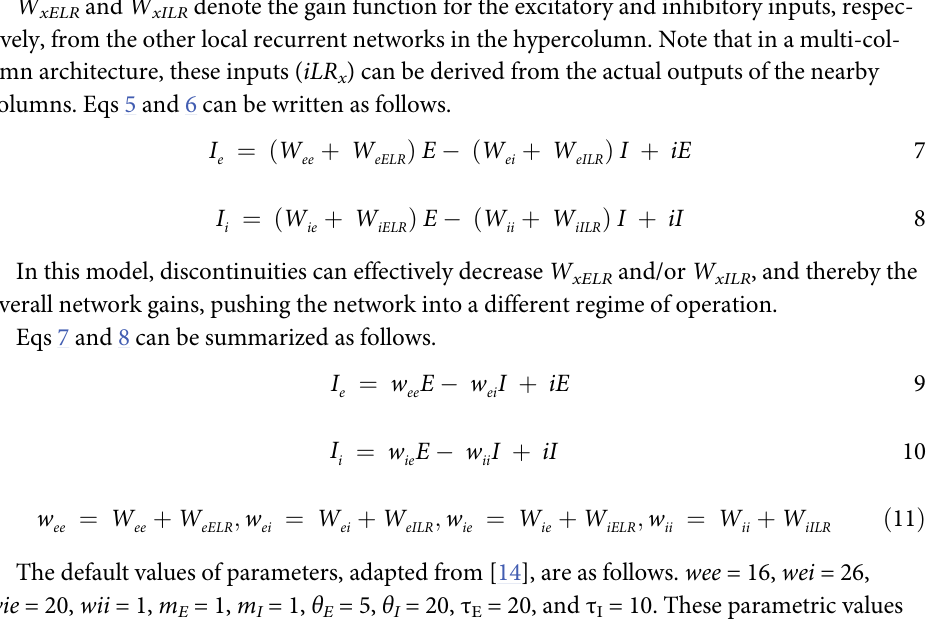
S1 Fig. RF mapping. (A) Magnitude of the evoked response produced by mapping stimuli (for details, see Materials and methods) is shown across the grid of electrodes, averaged across RF mapping sessions (7 sessions each in M1 and M2). (B) Electrodes showing a response above an arbitrary threshold (100 for M1, 60 for M2) are chosen as consistently good elec- trodes (indicated in red) for further analyses. (C) A color-coded schematic of the physical microelectrode grid and (D) the corresponding RF centers of these sites in the visual space determined as per the mapping algorithm described in the Materials and methods. Mapping based on firing rates (MUA) was done similarly by using the change in mean firing rate from baseline to stimulus period as the “response” metric. (E) Scatter of the estimated azimuth and elevation of RF centers for the selected electrodes. The RF center estimated from LFP and MUA were closely matched in both monkeys. (F) Scatter of RF size across the selected elec- trodes. Mean sizes are shown in red. Figure data are located at https://doi.org/10.5281/zenodo. 6523772. LFP, local field potential; M1, Monkey 1; M2, Monkey 2; MUA, multiunit